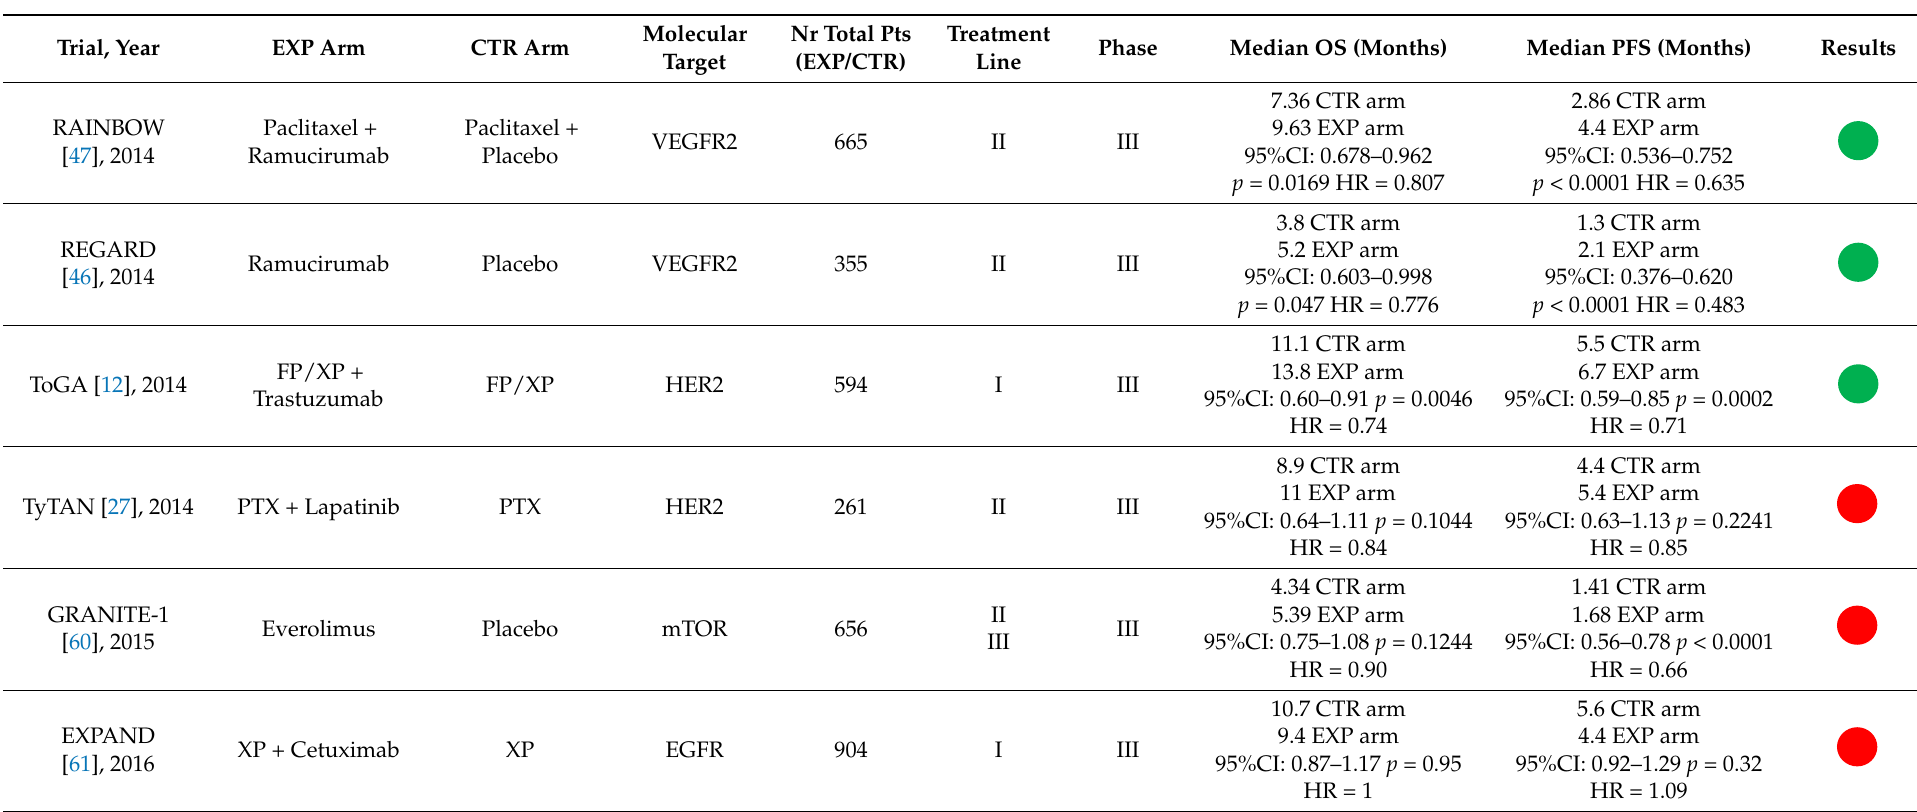
Table 1. Results of phase II and III trials. This table summarizes recent phase II and III RCTs investigating novel molecular agents’ survival outcomes. Unfortunately, most of these trials did not show any overall and progression free survival advantages as compared to conventional chemotherapy (red dot). Positive and partially positive studies have been pointed out with green and orange dot, respectively.